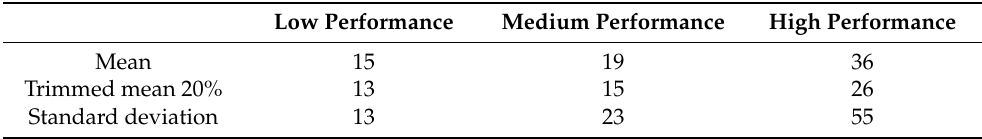
Table 2. Mean, trimmed mean and standard deviation of the number of desks in open space by performance category (units).